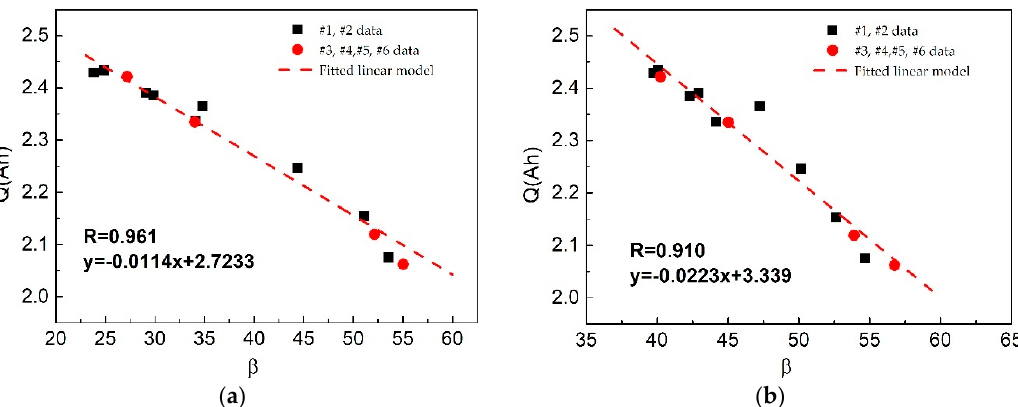
Figure 15. Fitted linear model of β -based capacity estimation method. ( a ) 70% SOC under charging condition; ( b ) 40% SOC under discharging condition.